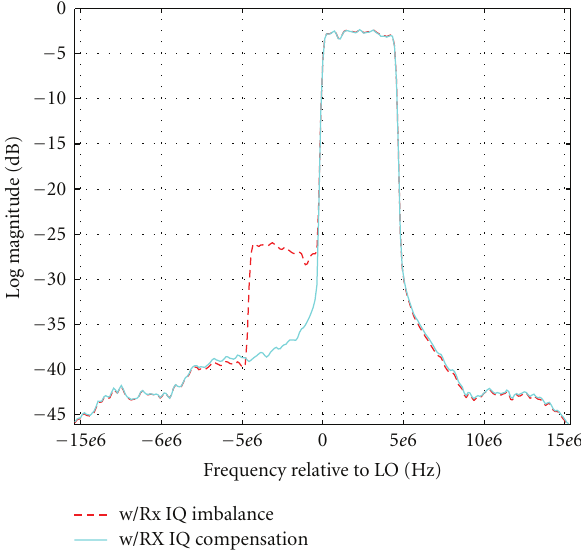
Figure 13: Comparison of measured I/Q demodulator output before and after I/Q imbalance